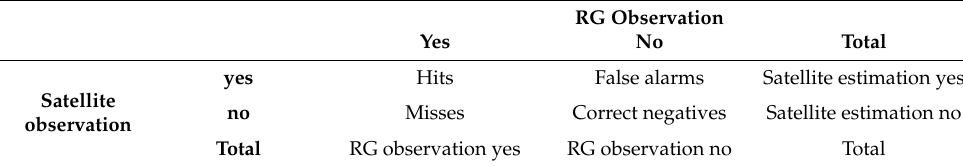
Table 1. Contingency